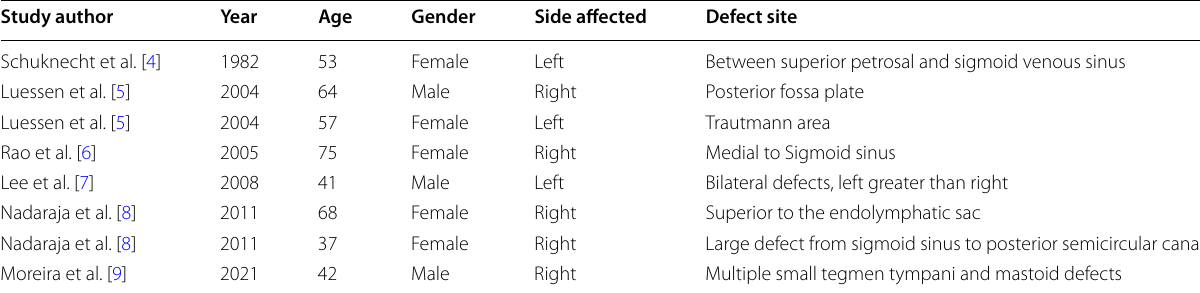
Table 1 Site of CSF leaks in temporal bone in various studies—table adapted and modified from study by Nadaraja et al.